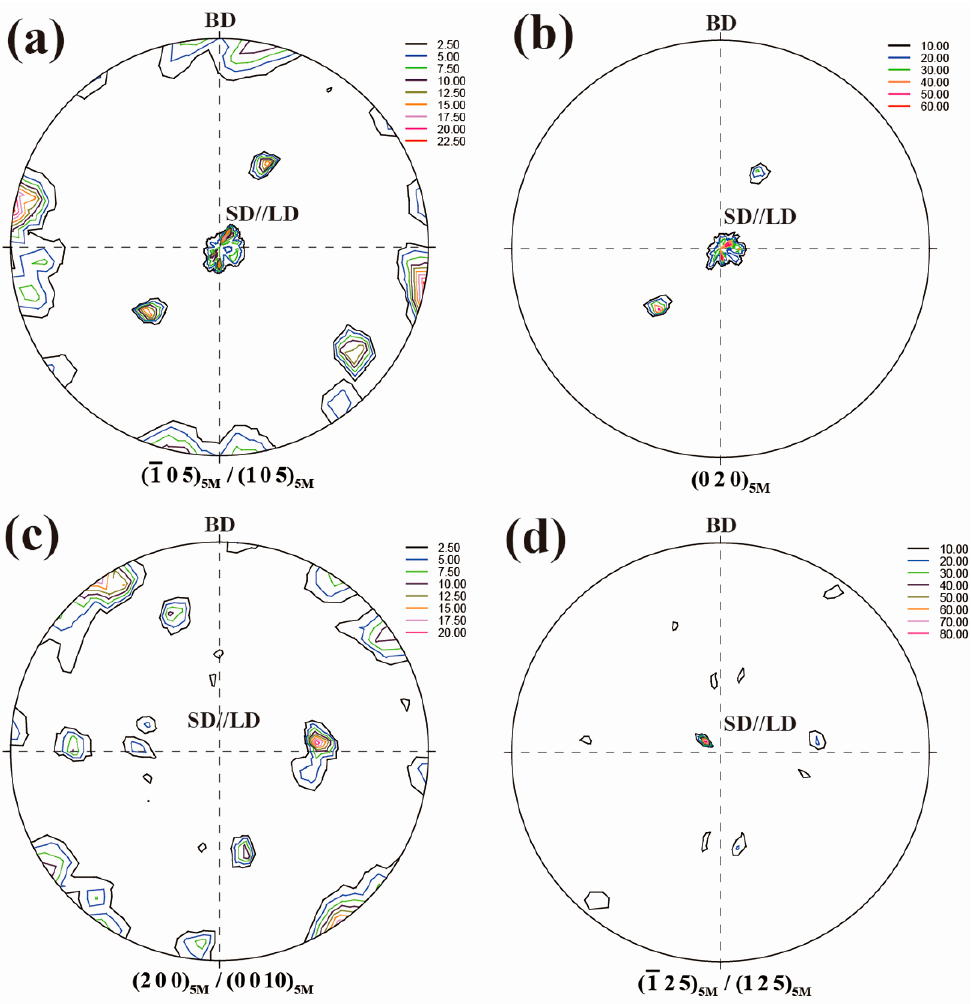
Figure 7. Pole figures of directionally solidified Ni 50 Mn 28.5 Ga 21.5 alloy after five cycles of thermo-mechanical treatment: ( a ) {1 0 5} 5M /{ − 1 0 5} 5M pole figure; ( b ) {0 2 0} 5M pole figure; ( c ) {0 0 10} 5M /{2 0 0} 5M pole figure; and ( d ) {1 2 5} 5M /{ − 1 2 5} 5M pole figure (BD: incoming beam direction; SD: solidification direction; LD: loading direction) [38].